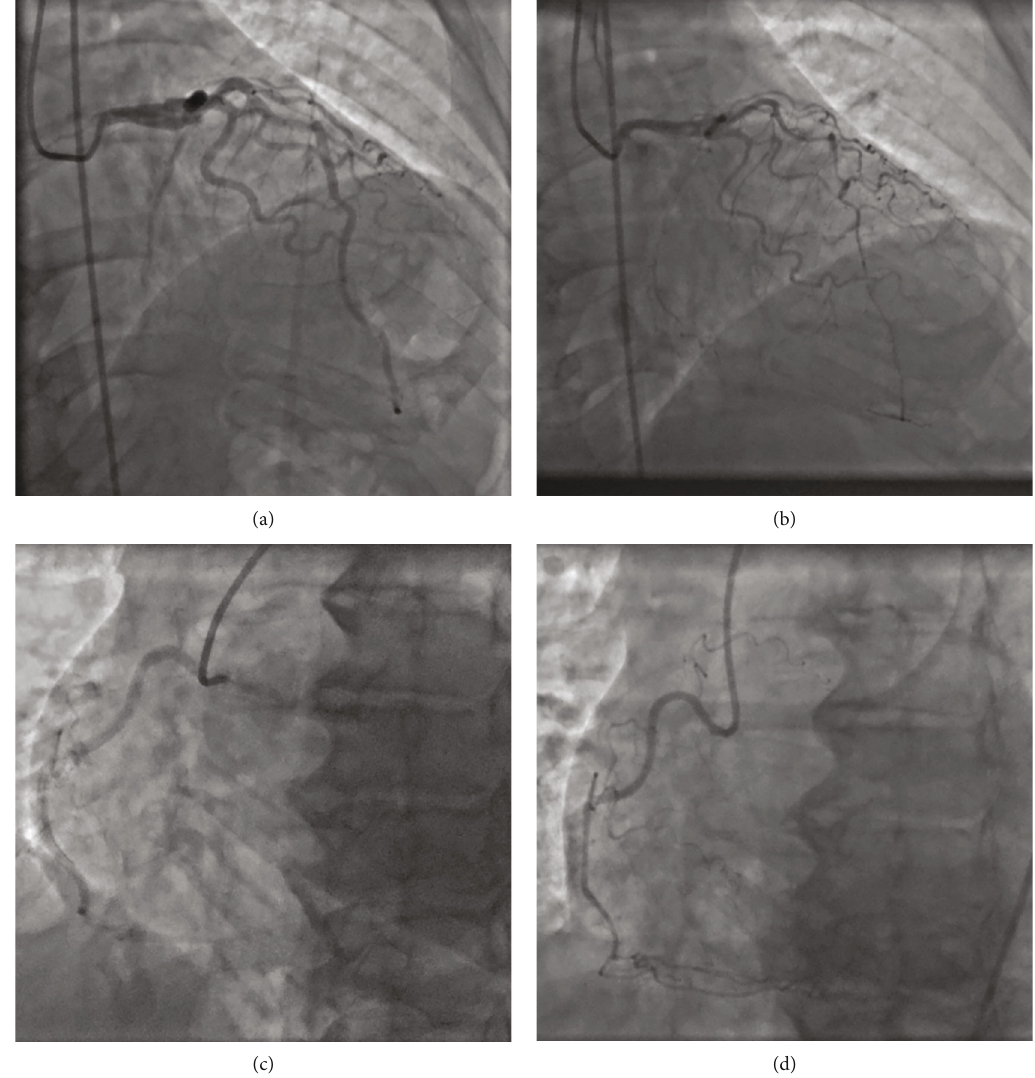
Figure 2: Coronary angiography demonstrates (a) normal left coronary artery system three years prior, (b) di ff use severe LAD and LCx vasospasm, (c) normal right coronary artery system three years prior, and (d) mild RCA